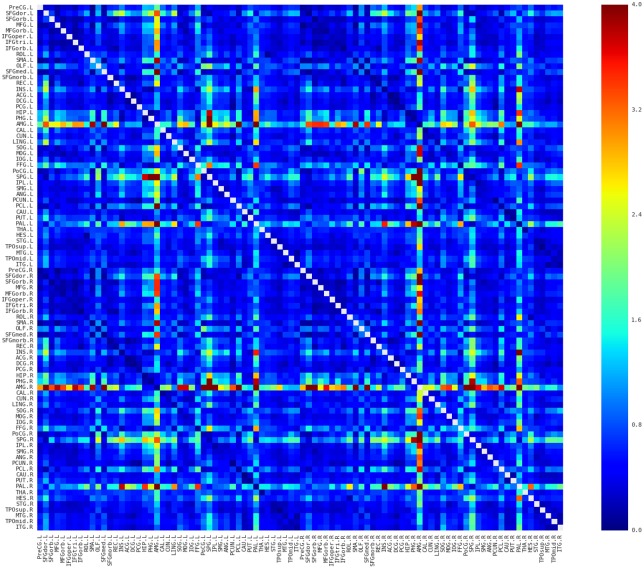
Coefficient of variation (CV) map of the connectivity matrices.Red and blue color indicates high and low dispersion of that connection across participants, respectively. Most of the connections possessed relative low CV and in particular the connections with relative high similarities showed low CV, suggesting relative high consistency across subjects. Main diagonal (i.e., self-connection) is indicated in white and excluded from following analyses. L, Left; R, Right.